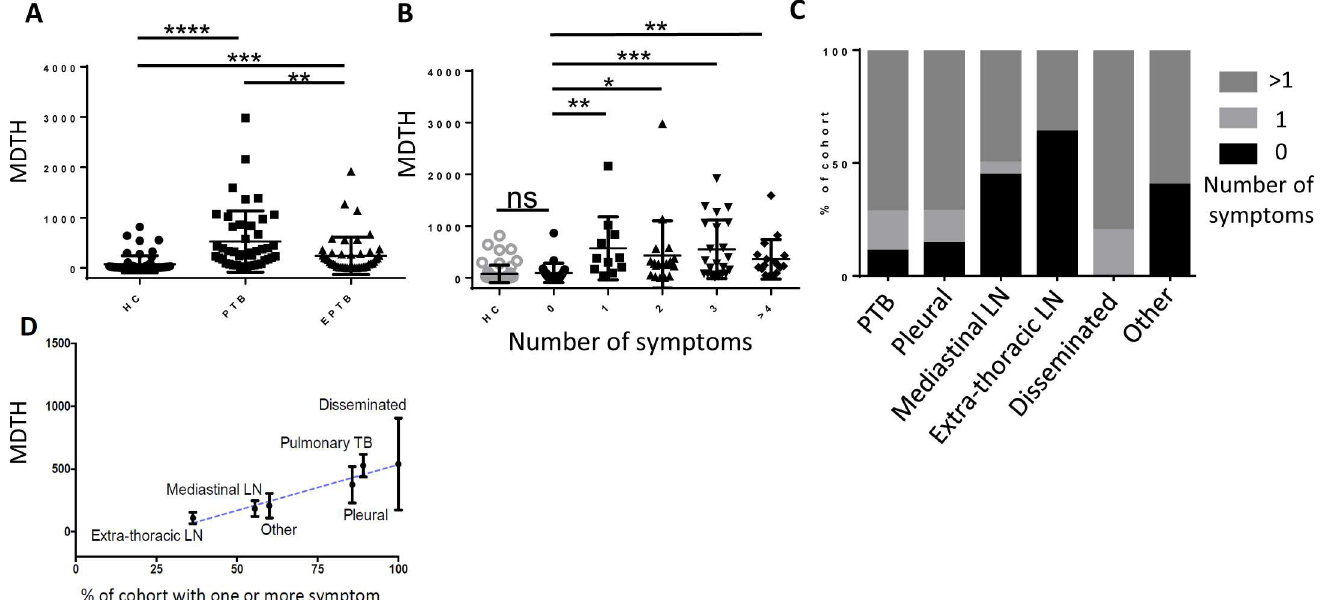
Fig 3. Molecular distance to health is linked to symptoms status and site of disease. (A) Molecular distance to health (MDTH) calculated for each individual(from 3409 transcripts which represent the transcripts of the 38 annotatedmodules shown in Fig 2A, healthy controls used as the control group). Individuals groupedby disease status, (median value, error bars SD) statistical testing Kruskal Wallis with Dunn’s multiple testing correction. (B) Patients groupedby number of reported symptoms; night sweats, fever, weight loss, chest pain or cough (median value, error bars SD) statistical testing Kruskal Wallis with Dunn’s multiple testing correction. (C) Patients groupedby site of disease and number of reported symptoms (as previous). (D) Mean MDTH (error bars, Standard error of the mean) plotted for each site of disease against % of the cohort suffering from one or more symptom (from list of symptoms describedpreviously). Blue line represents Pearson’s correlation (R 2 0.95, p = 0.0090).